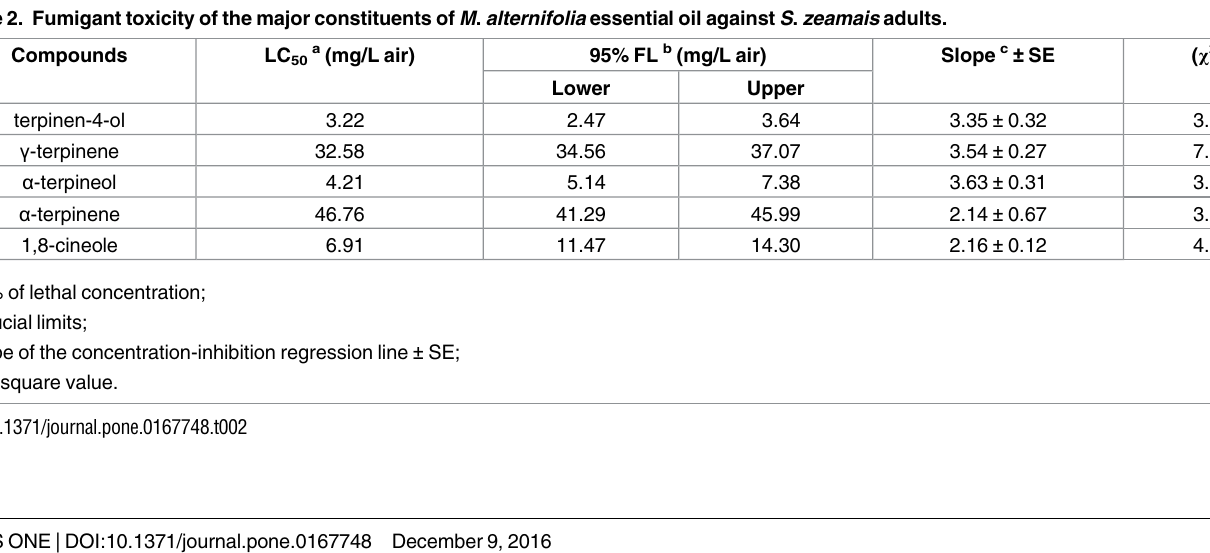
The mean value of corrected mortality (calculated from three independent experiments) was compared and separated using the Scheffe’s test with a p value < 0.05. The LC 50 values were subjected using the Probit analysis. a Means within a column followed by the same letters are not significantly different ( p < 0.05); b 50% of lethal concentration (mg/L air); c Fiducial limits; d Chi-square value.